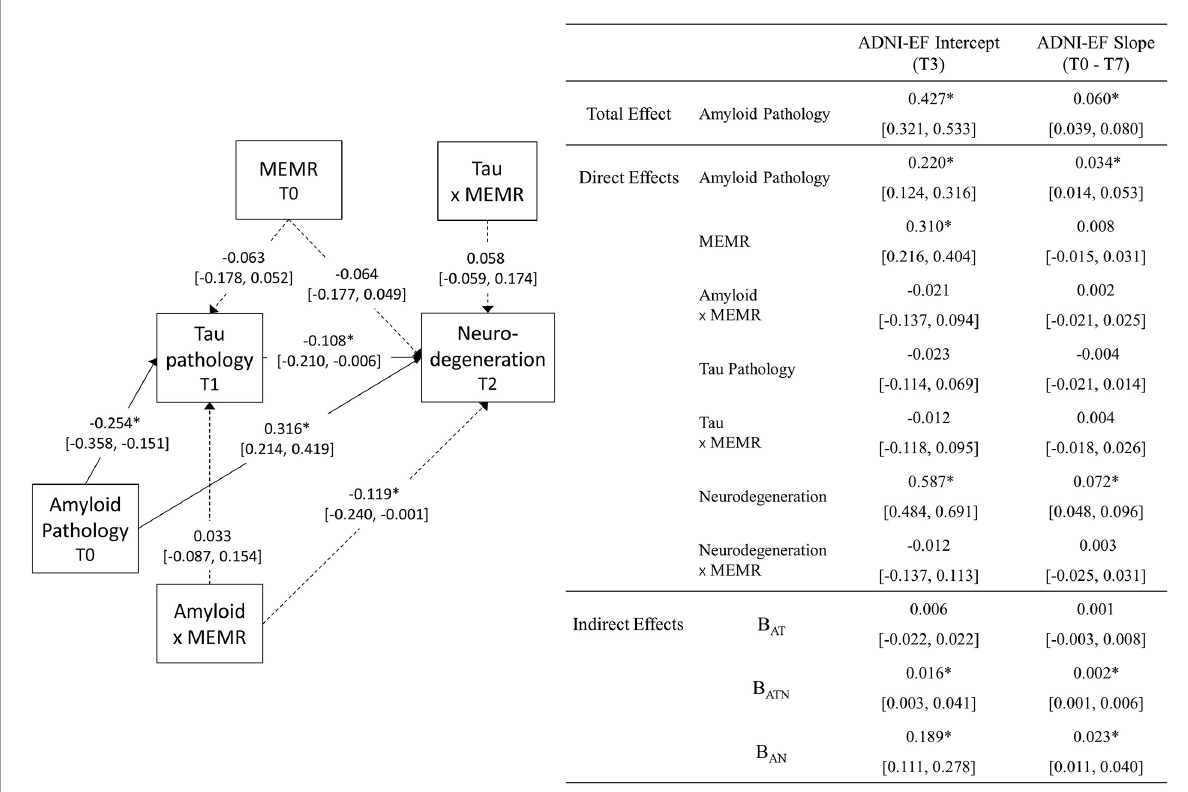
FIGURE3 Unstandardized estimates (95% CI) of the parameters obtained from the moderated sequential mediation model ( N = 332). Parameter estimates that are significant at the p < 0.05 level are marked with *. The 95% CIs for the indirect effects (bottom-right of figure) are bias-corrected bootstrapped confidence intervals (2,000 draws), obtained from a model estimated using the average residual reserve index (MEMR) plausible values. All other 95% CIs are symmetric intervals ( ± 1.96 standard errors) obtained by pooling results from 30 imputed datasets. Dashed lines are used for illustrative purposes, to signify paths that relate to the moderating effect of MEMR; solid lines relate to mediation relationships. Biomarkers used were the ratio of CSF β -amyloid 1 - 42 to β -amyloid 1 - 40 (A β 42 /A β 40 ) for amyloid pathology; plasma phosphorylated tau 181 (p-tau181) for tau pathology; and uptake of 18 F fluorodeoxyglucose tracer (FDG metabolism) in AD-specific regions of interest for neurodegeneration. ADNI-EF denotes ADNI’s composite measure of executive function. B AT , the amyloid → tau → ADNI-EF indirect effect; B ATN , the amyloid fect; B neurodegeneration → ADNI-EF indirect effect; B AN , the amyloid → neurodegeneration → ADNI-EF indirect